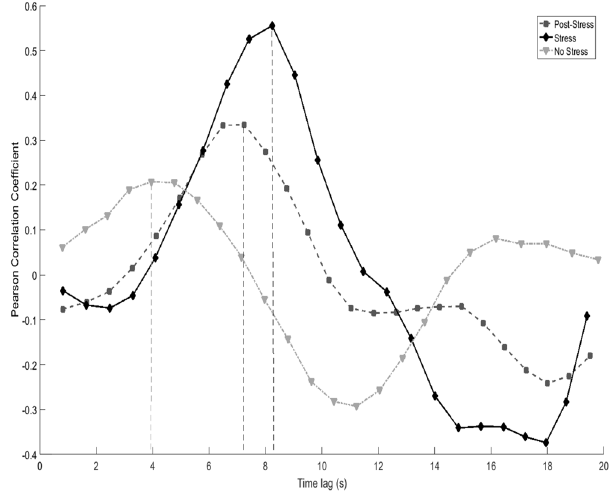
Figure 2. Visual representation of time lag analysis. This data represents one subject. Each line represents the correlation of observer’s IBI with speaker’s IBI, for each video type. As the time lag is increased from zero, we are able to determine at what time the maximum correlation is achieved.